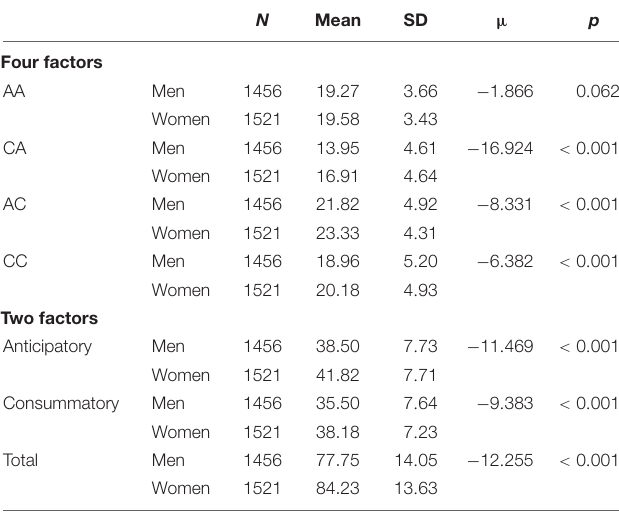
TABLE 1 | Descriptive data and gender differences on factors of